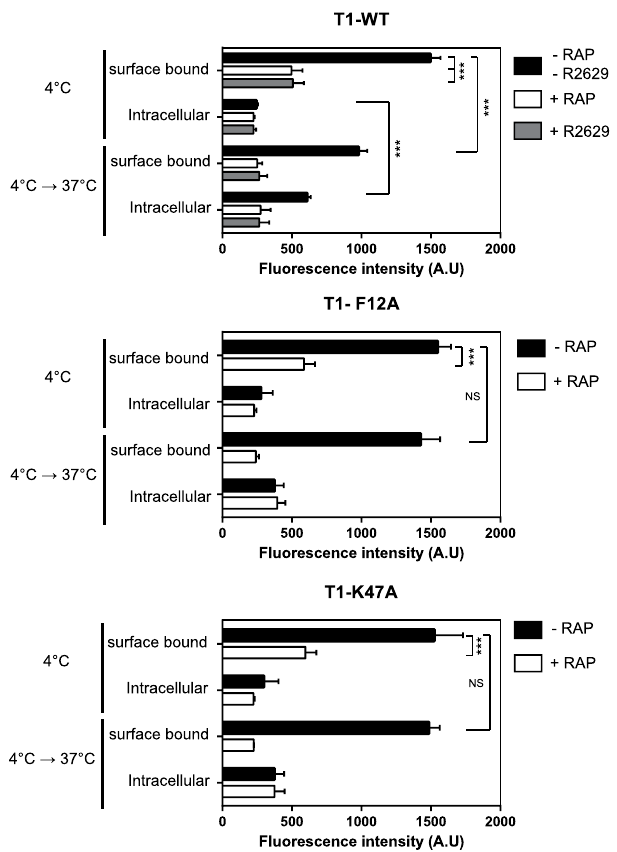
Figure 6. Biochemical analysis of LRP-1-mediated endocytosis of wild-type TIMP-1 and mutants. Cortical neurons from mouse embryos cultured for 48 h on poly-L-lysine-coated coverslips were incubated at 4 °C for 1 hour with 5 nM fluoT1-WT, fluoT1-F12A or fluoT1K47A in the presence or absence of 500 nM RAP or 30 µ g/mL of blocking LRP-1 polyclonal antibodies (R2629). After careful washing, part of the cells was used to quantify the surface bound and intracellular signal at 4 °C. The other part was then incubated at 37 °C for an additional 10 min to quantify the surface bound and intracellular signal. Fluorescence intensity was quantified by spectrophotometry and expressed as arbitrary units (A.U.). Values below 300 A.U. are considered to be nonspecific. Error bars indicate mean ± SD, *** indicates significantly different with a P-value < 0.001 and NS indicates a value that is not statistically